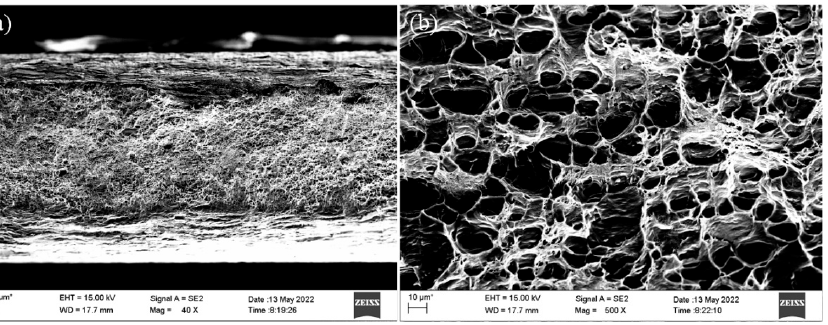
Figure 7. Fracture characteristics of the tensile specimen: ( a ) macroscopic feature; and ( b ) microscopic feature.